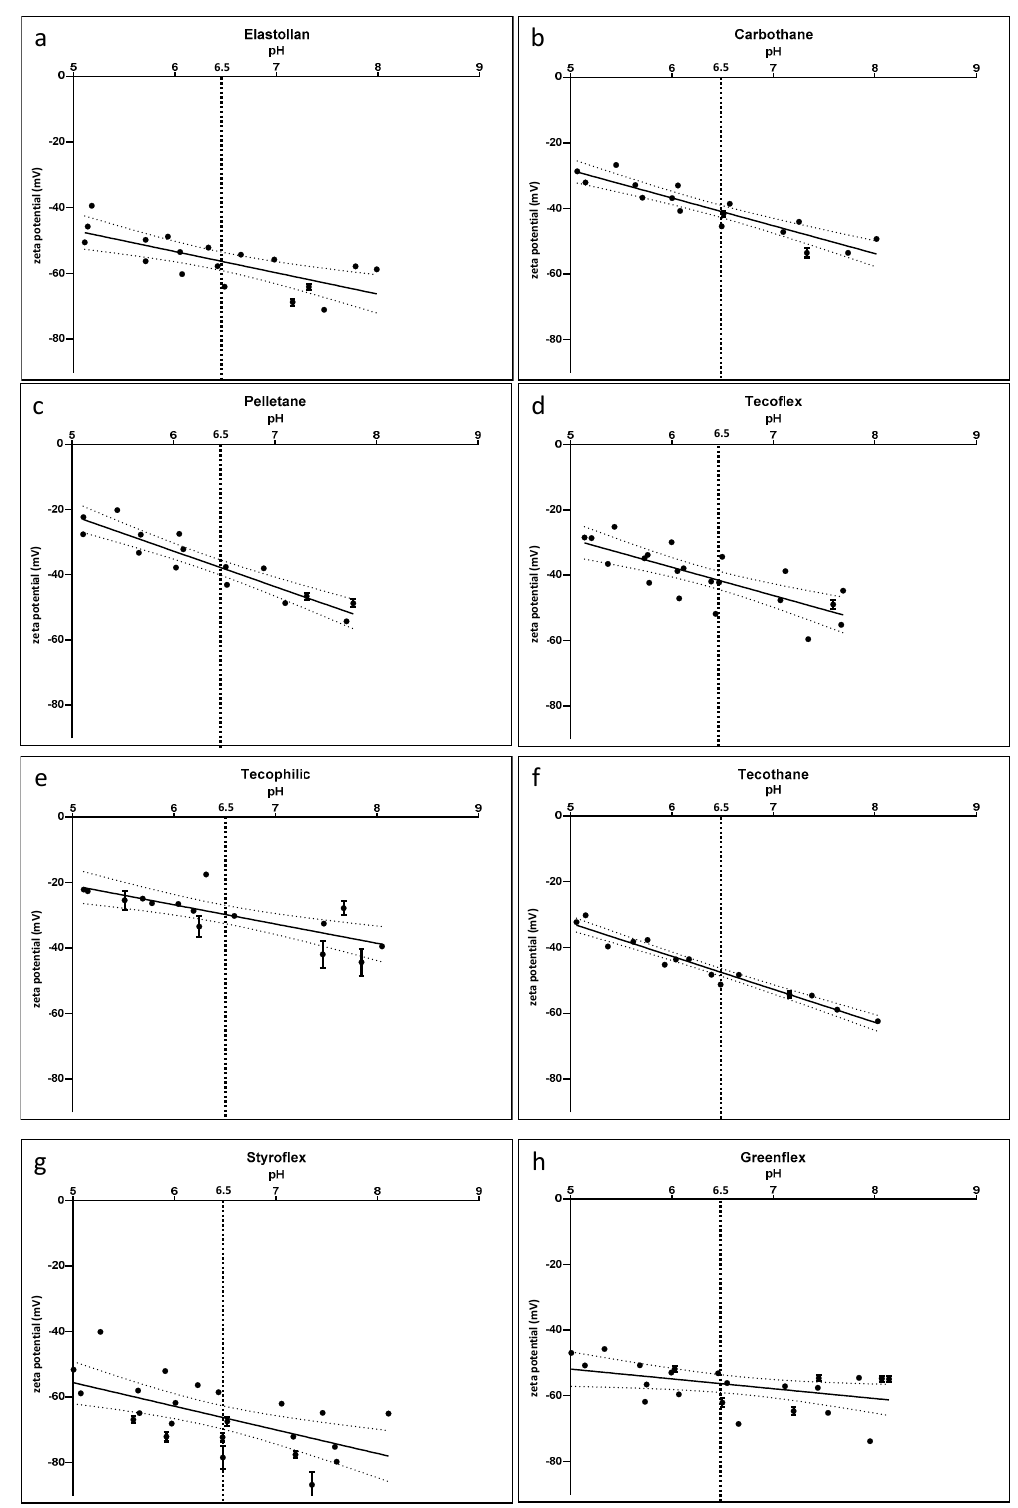
Figure 3. Zeta potential of the polymers Elastollan ( a ), Carbothane ( b ), Pelletane ( c ), Tecoflex ( d ), Thecophilic ( e ), Tecothane ( f ), Styroflex ( g ) and Greenflex ( h ). The absolute values show a variation (with lowest absolute values for Styroflex, Greenflex, and Elastollan), while the slope of the curves is similar for all samples: decreasing zeta potential with increasing pH. pH 6.5 marks the average pH for urine. mean ± SD. Solid line marks mean, while dotted line shows the 75% confidence interval. n = 3 independent samples (SurPASS, Anton